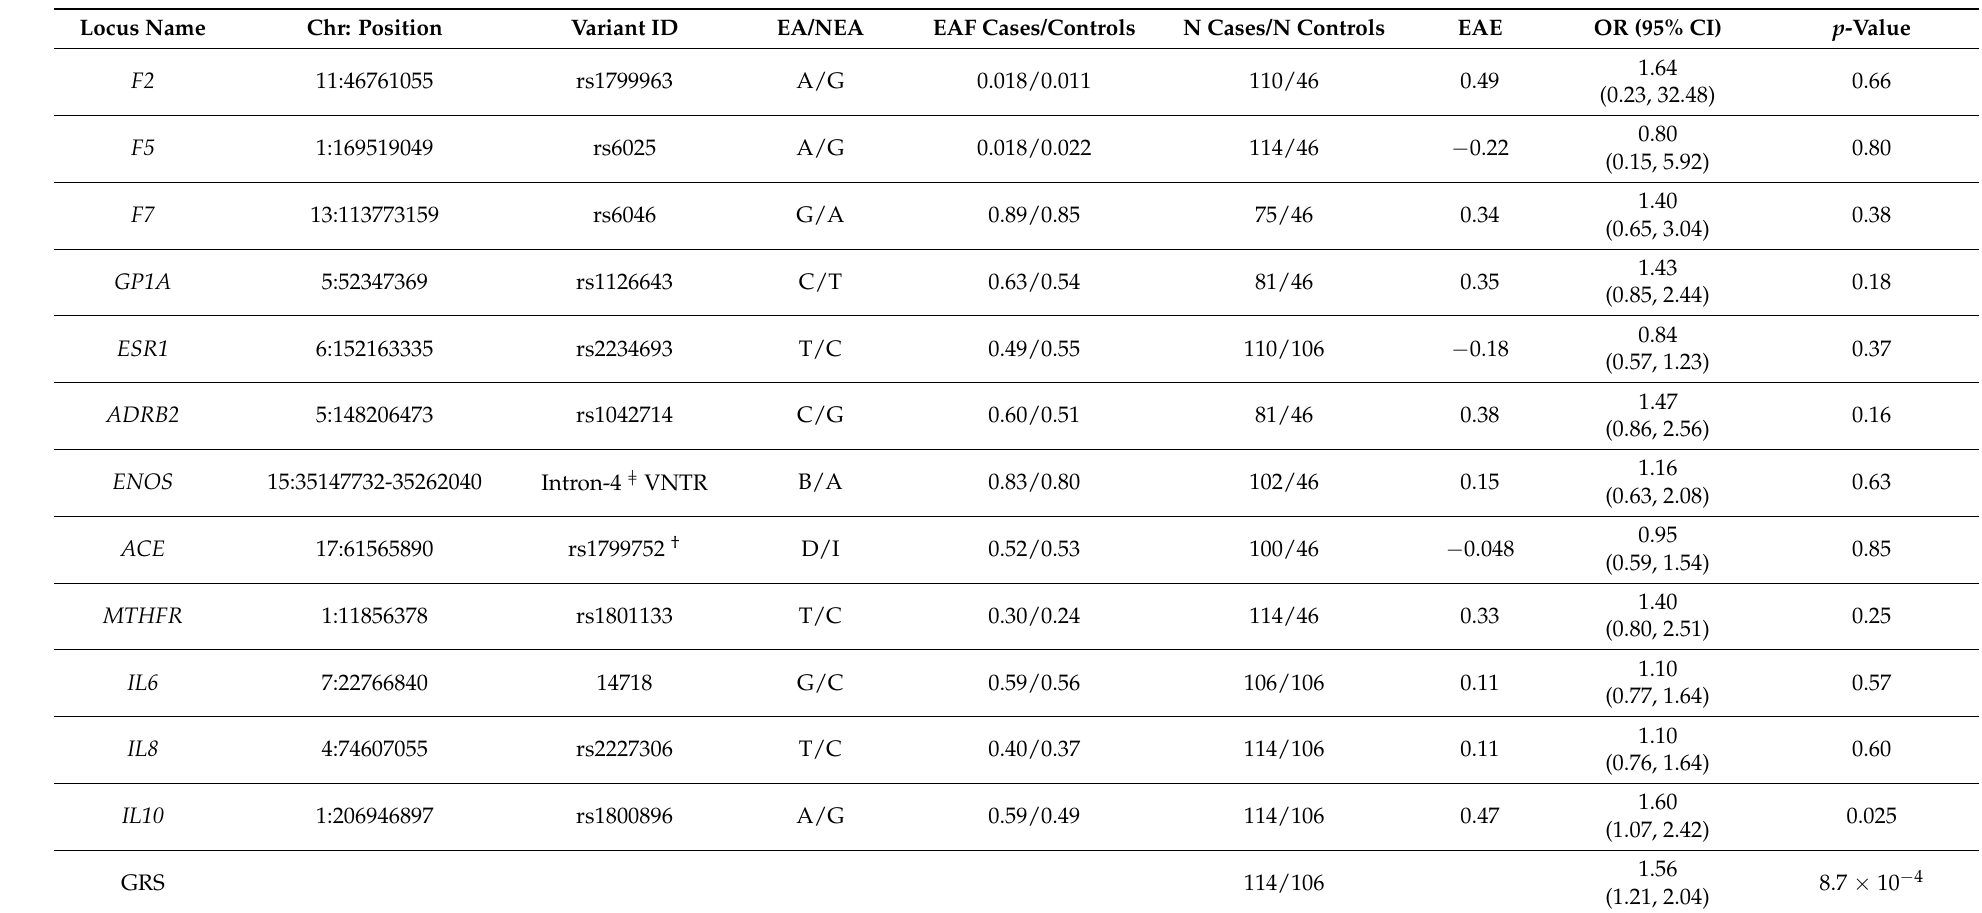
Table 2. Associations between 12 previously reported genetic variants and RPL in the REPLIK